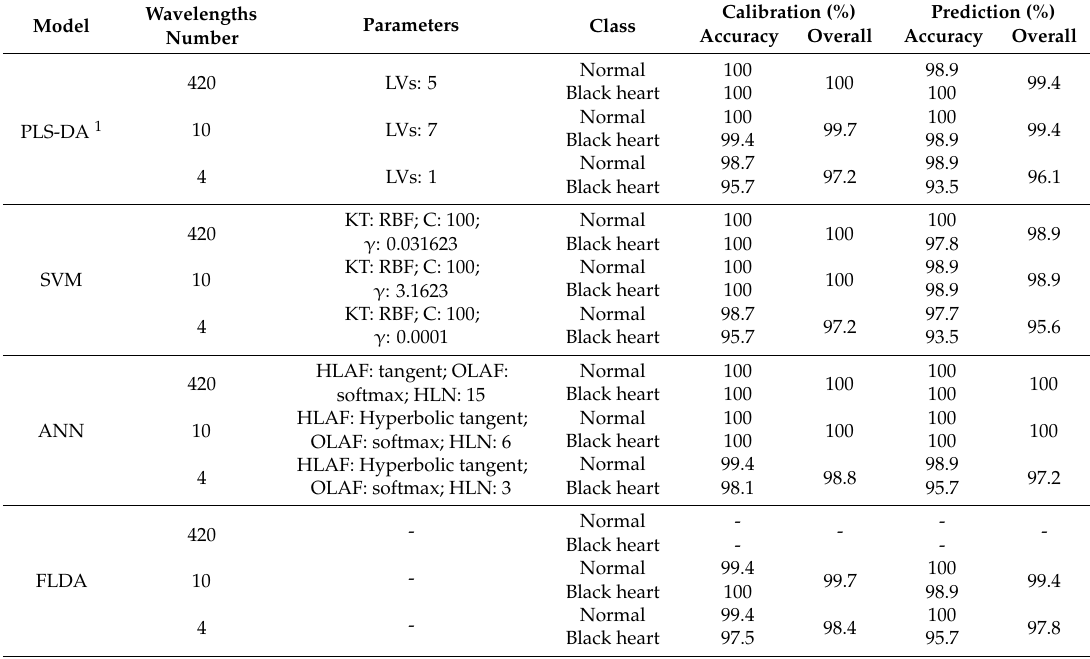
Table 3. Classification results (%) for normal and defective radishes with black heart based on transmittance using four